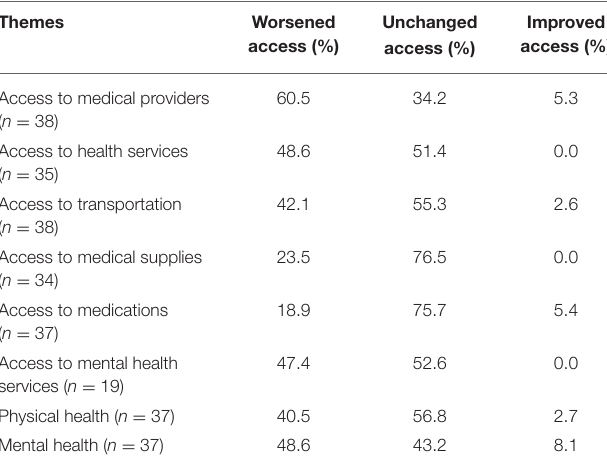
TABLE 2 | Self-reported worsened, unchanged, and improved life situations during the coronavirus pandemic.